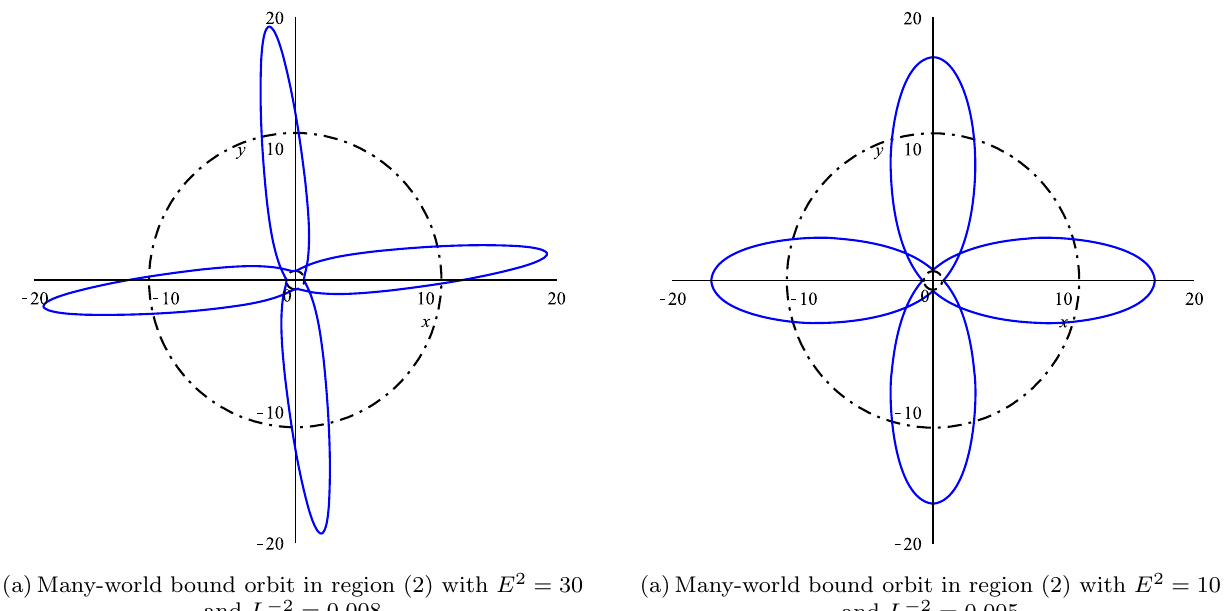
Fig. 2 Timelike geodesic in the charged BTZ black hole with (cid:4) = − 0 . 1 , m = 2, q = 1 . 5 and r = 1 . 08. The dash dotted lines represent 0 0 the horizons